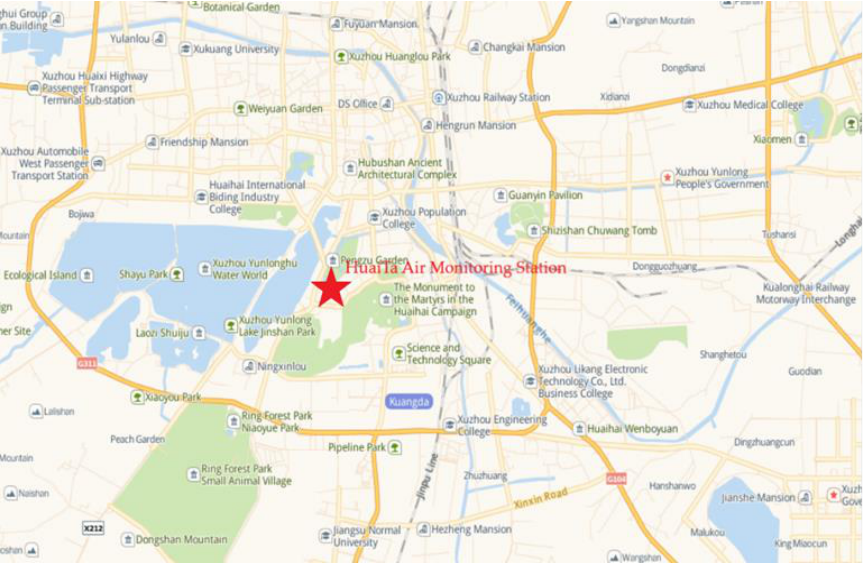
Figure 2. Location map of air monitoring stations.